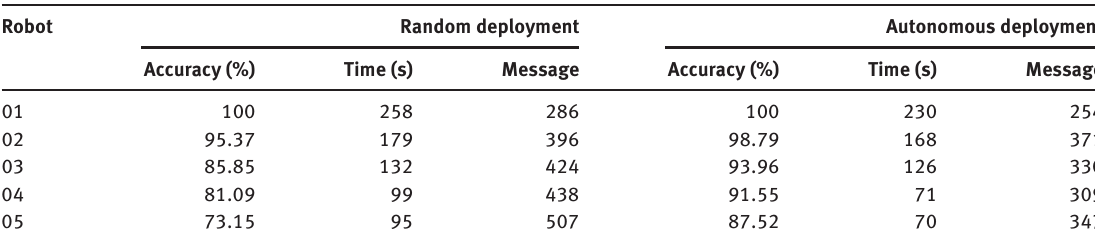
Table 7: Average for 20 Trials of the Previous Scenarios: Accuracy of the Global Generated Maps, Time of Mapping, and Number of Exchanged Messages.